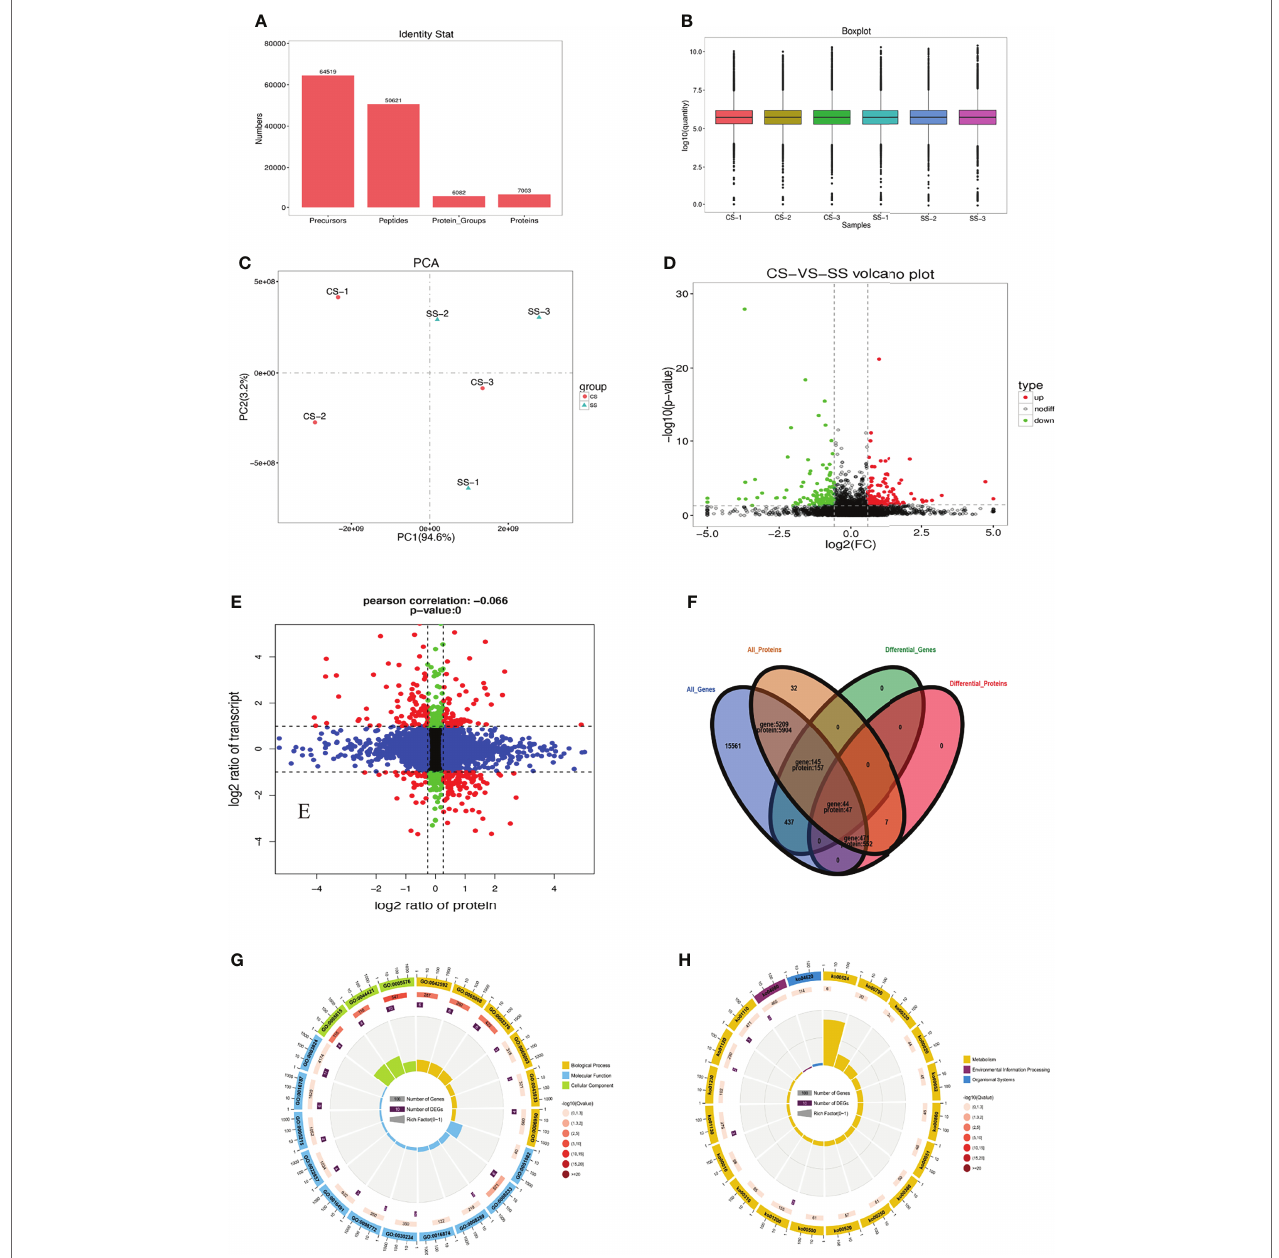
FIGURE 4 | Statistics of protein identification by DIA. (A) Statistics of identified proteins by DIA. (B) Normalized comparison of all samples. (C) PCA compared the differences in protein among the CS and SS groups. (D) A volcano map of DEPs. (E) A nine-quadrant diagram of protein and transcriptome association analysis. (F) Venn diagram of protein and transcriptome association analysis. (G) Significant difference genes and significant difference proteins by GO enrichment. (H) Significant difference genes and significant difference proteins by KEGG